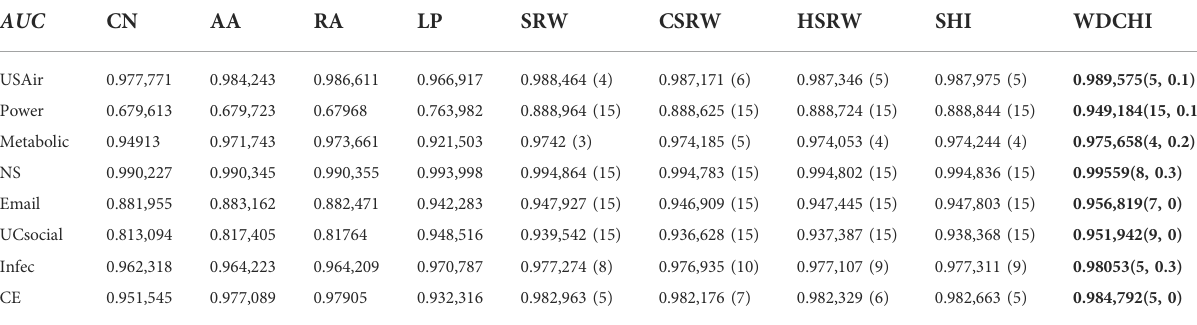
TABLE 3 AUC on the twelve benchmark networks with L = 100 as the line rate. Every data point is a random 90% – 10% divide of the training set and testing set, with each point being an average of over 30 independent realization procedures. AUC